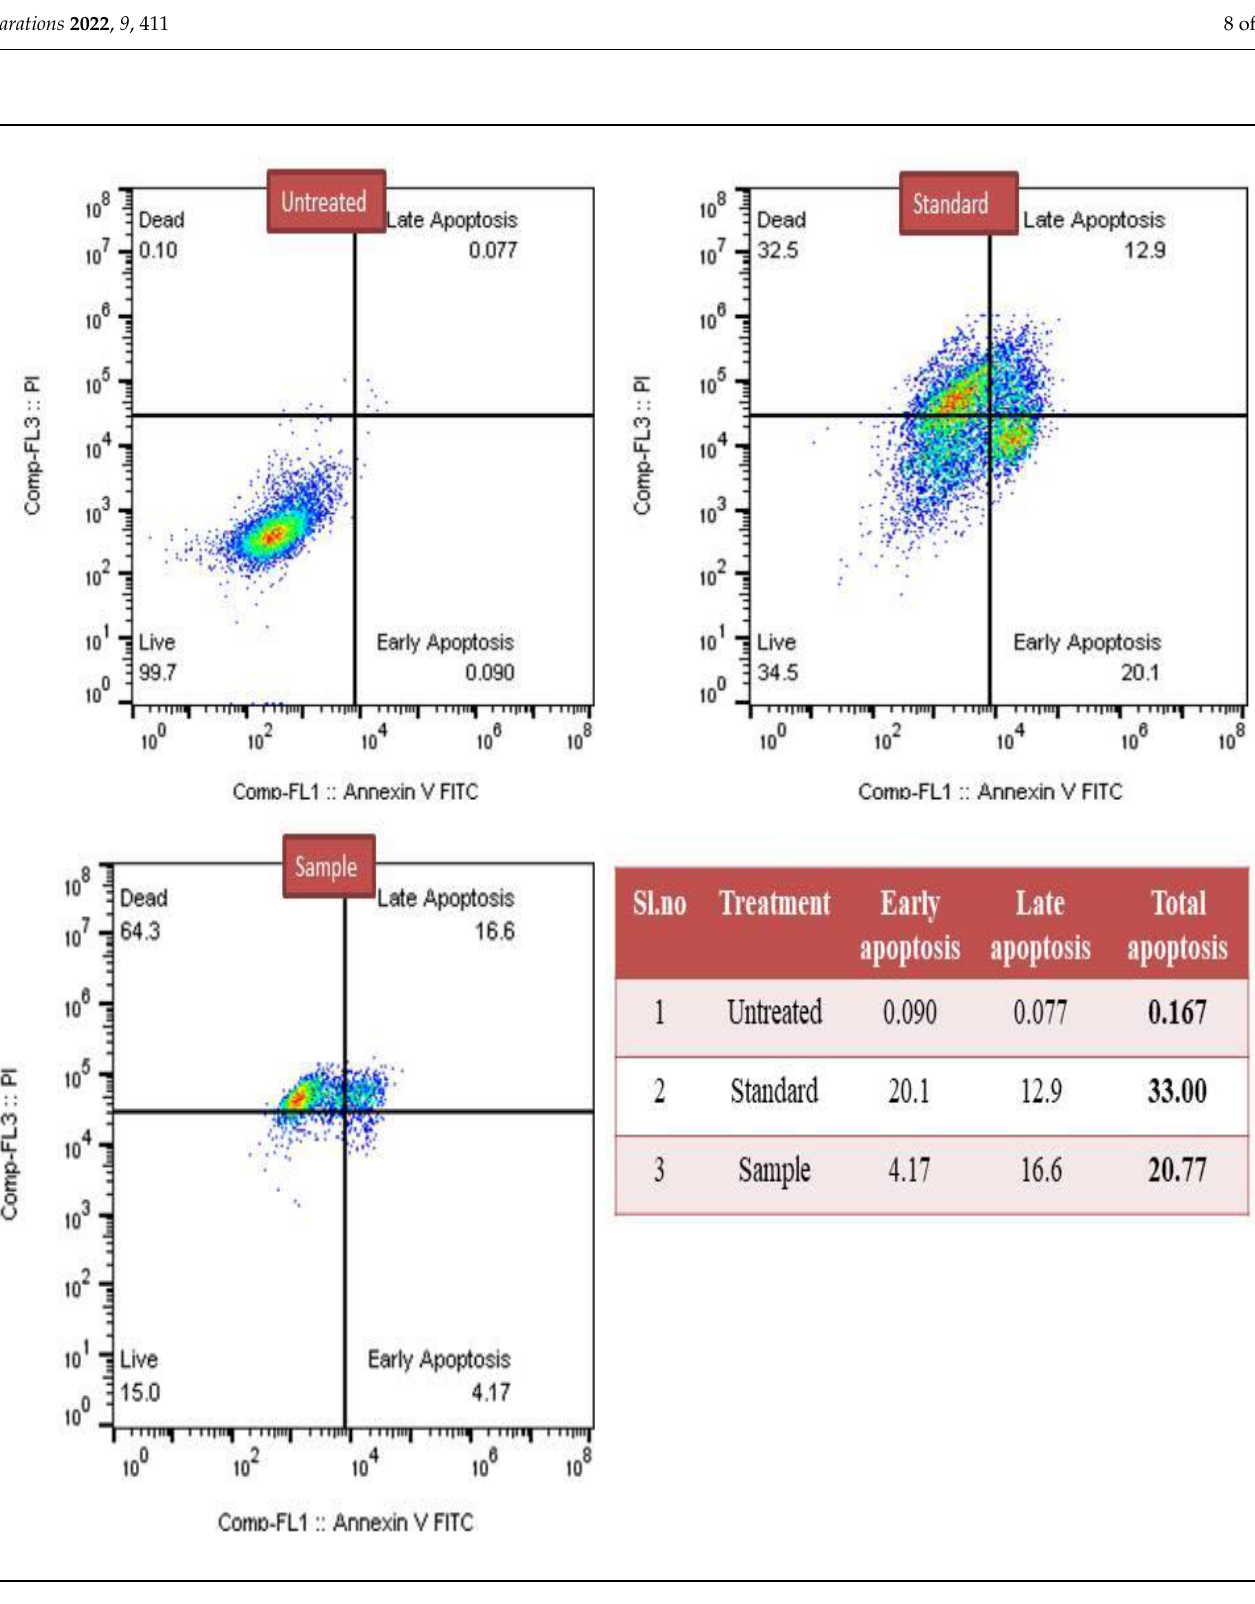
Figure 2. Detection of early and late apoptosis induced by methanol extract of C. colocynthis in the breast cancer MCF-7 cell line. breast cancer MCF-7 cell